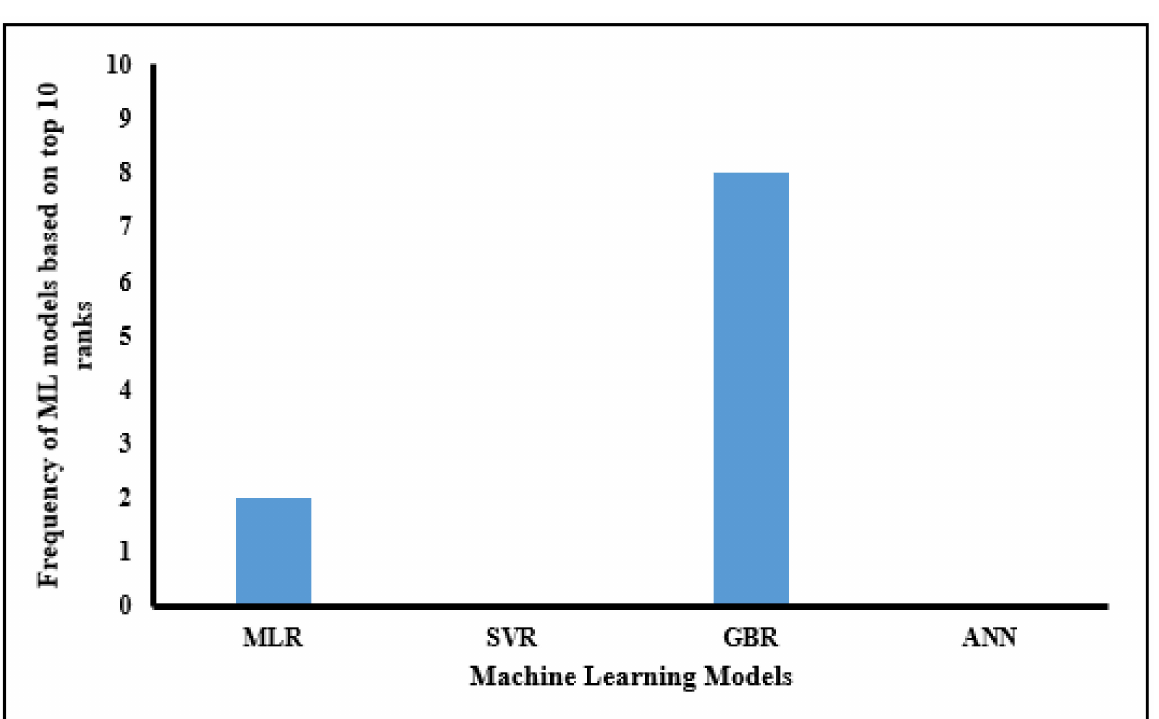
Figure 7. Frequency of ML models based on top 10 ranks by AR ranking